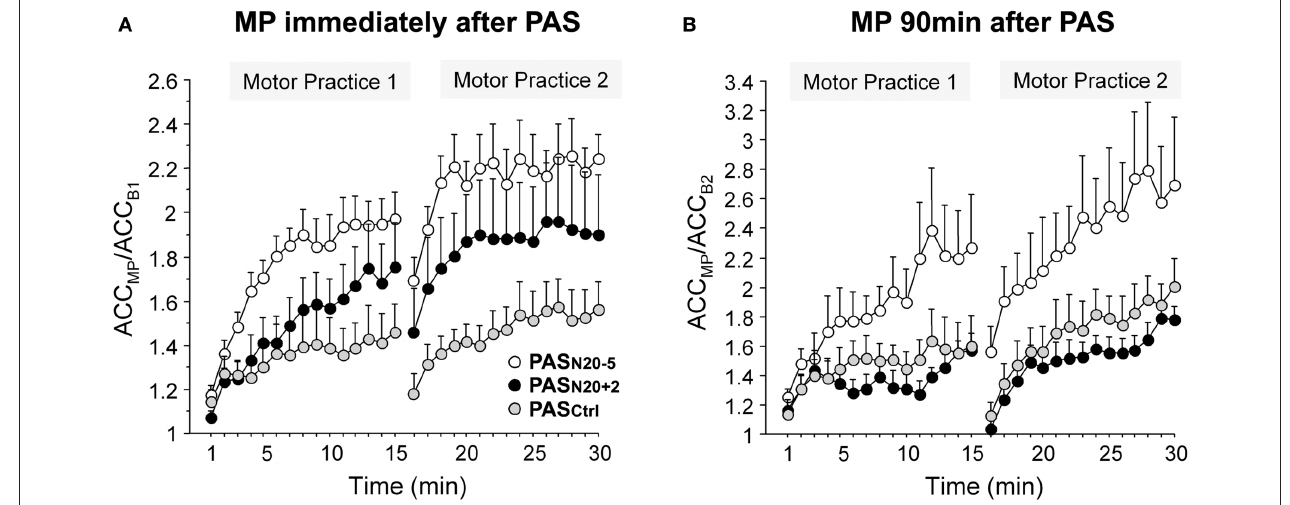
learning compared with priming by PAS (gray circles, control PAS condition Ctrl without induction of LTP/LTD-like plasticity). (B) In contrast, MP 90 min after PAS enhanced motor learning, whereas MP following PAS showed a N20 − 5 N20 + 2 trend toward depression of learning with respect to the PAS condition. Note Ctrl different scales of y -axes in (A) and (B) . Mean ± S.E.M. of nine subjects (adapted, with permission, from Figure 3 in Jung and Ziemann,